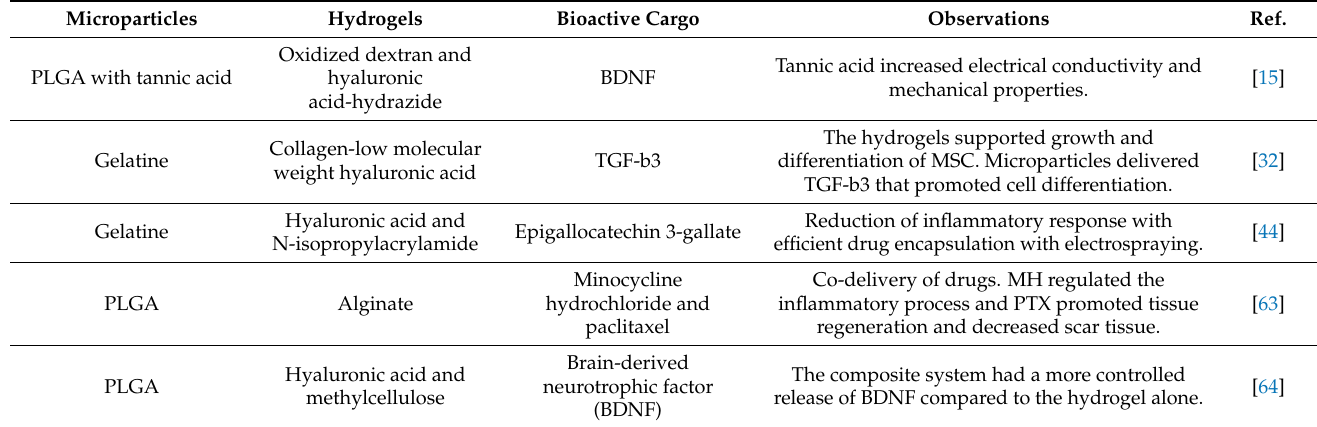
Table 3. Microparticles in hydrogel systems for spinal cord diseases